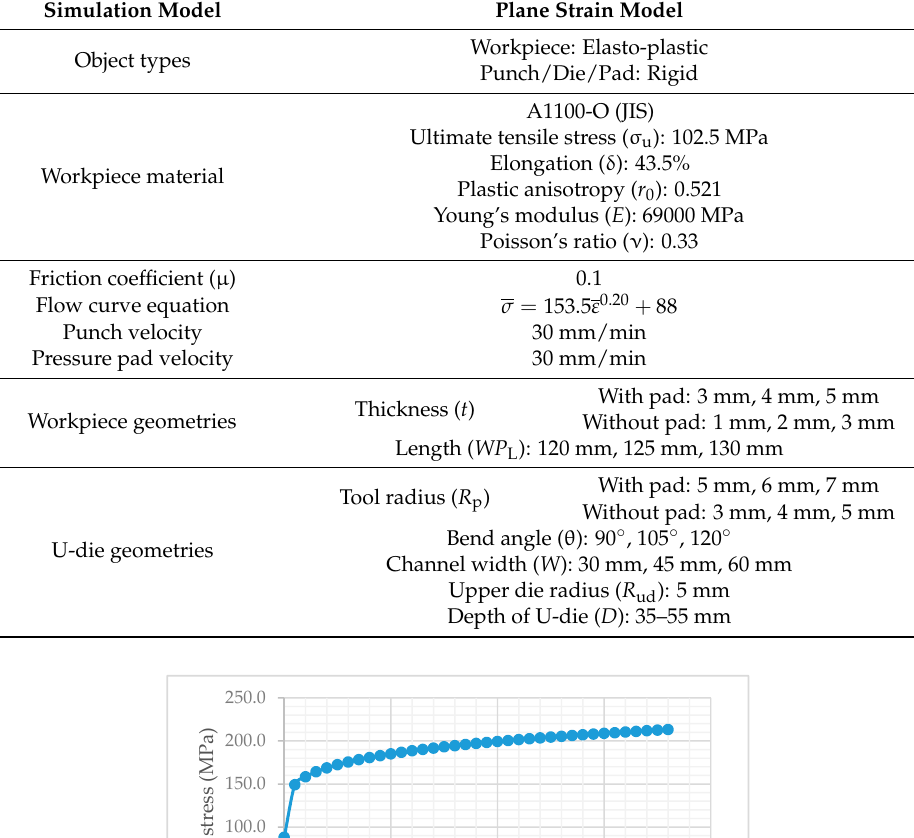
Table 1. FEM simulation and experimental conditions.